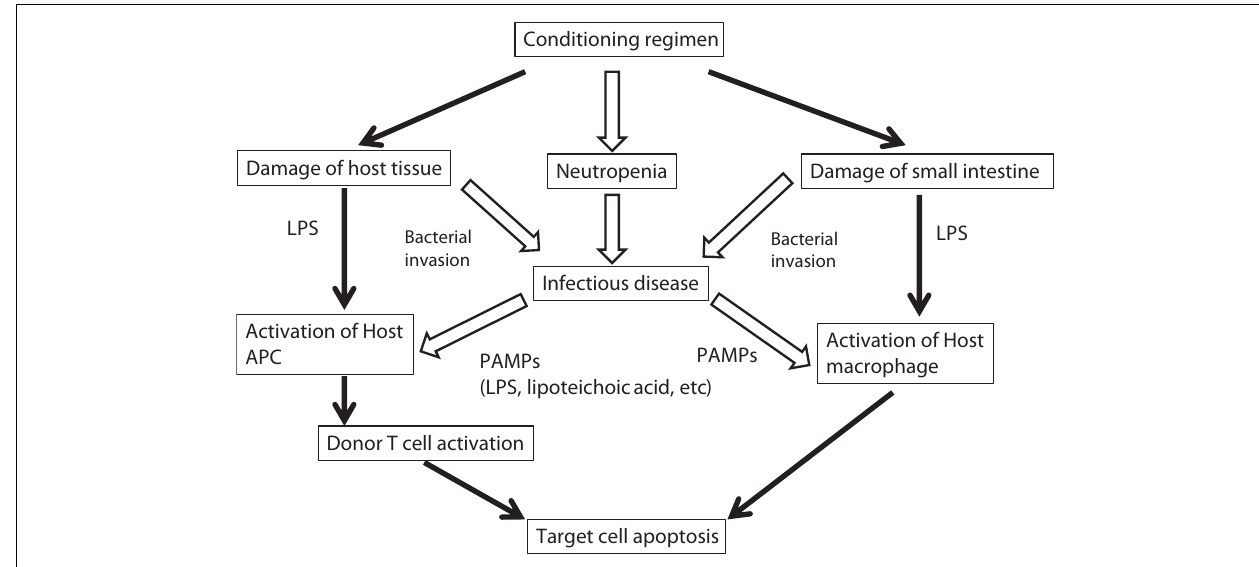
such as microbial products including LPS or other PAMPs, which further enhance activation of host APCs. In addition, conditioning regimen causes severe neutropenia that increased the risk of infectious disease. Infectious diseases increase the secretion of PAMPs, which activate host APCs. LPS, lipopolysaccharide; APC, antigen-presenting cell; PAMP, pathogen-associated molecular